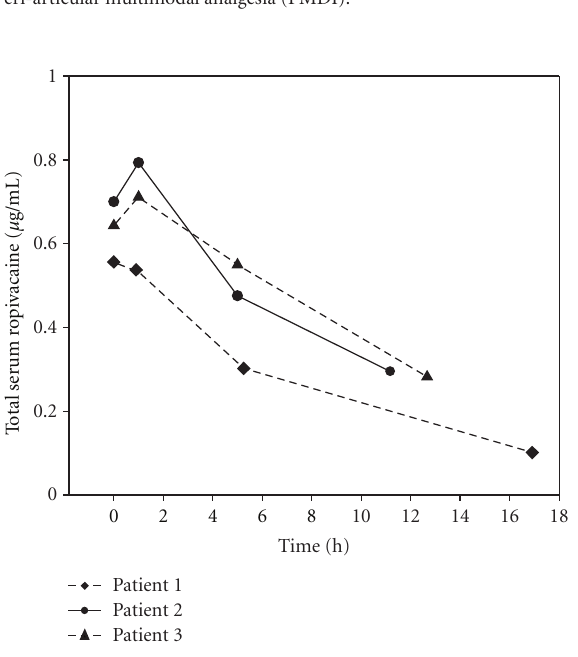
Figure 1: Serum concentration versus time profile of ropivacaine ( µ g/mL) for 3 patients that did not receive postoperational bolus